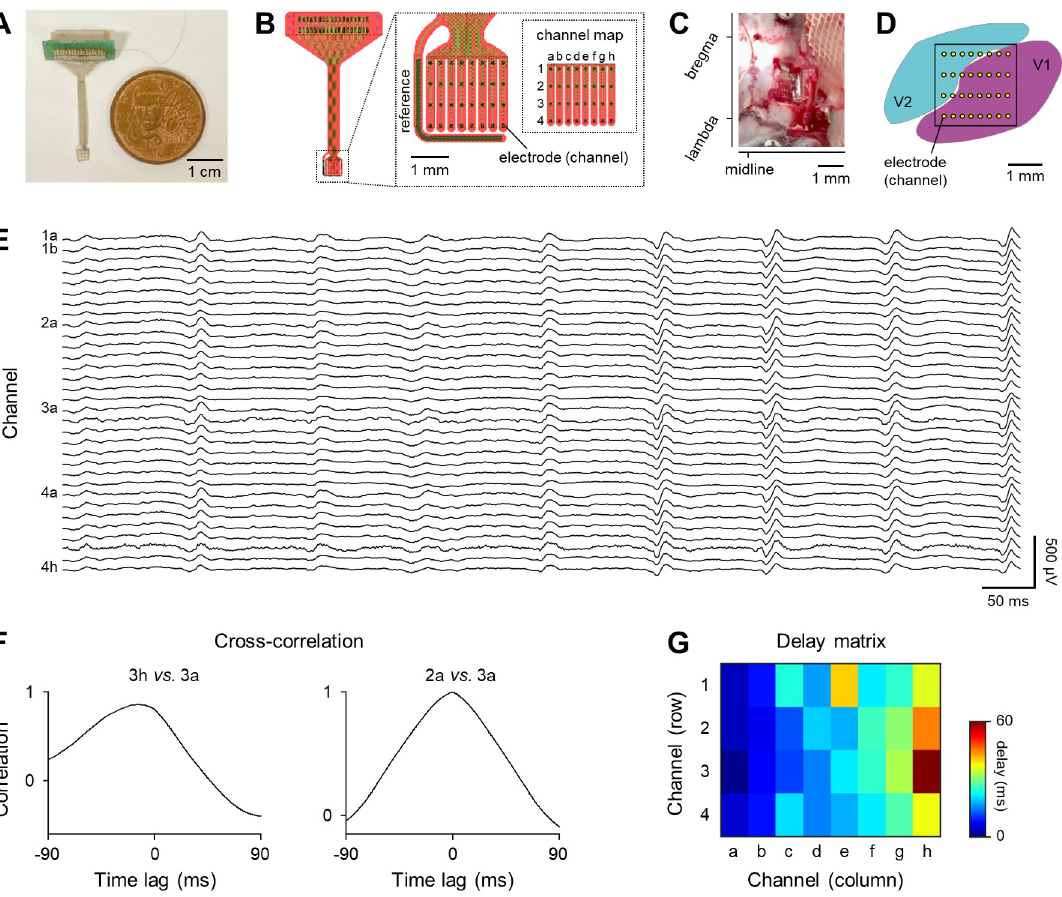
Fig 1. Propagation pattern of spontaneous neural activity in primary and secondary visual cortices recorded by 32-channel ECoG electrodes. A , A photograph of a custom-made 32-channel ECoG electrode array. B , A graphic diagram of the ECoG electrode array shown in A . A number and a letter were allocated to each channel to identify a row and a column, respectively. C , A photograph of a surgical window. The ECoG electrode array was placed on the cortical surface in the cranial window. D , The electrode array covered the surface of the primary and secondary visual cortices (V1 and V2, respectively). E , Representative traces of 0.9-s ECoG signals. Note that we defined a block of 0.9-s 32-channel ECoGs as an episode. F , Left : Representative cross-correlation function between ECoGs (shown in E ) recorded by the latest ( e . g ., 3h) and the reference ( e . g ., 3a) channels. Right : The same as left , but between the earliest ( e . g ., 2a) and the reference channels. G , A representative pseudocolored matrix of delay between ECoGs (shown in E ) recorded by the reference channel ( e . g ., 3h) and the other channels. Hot and cold colors indicate long and short delays,